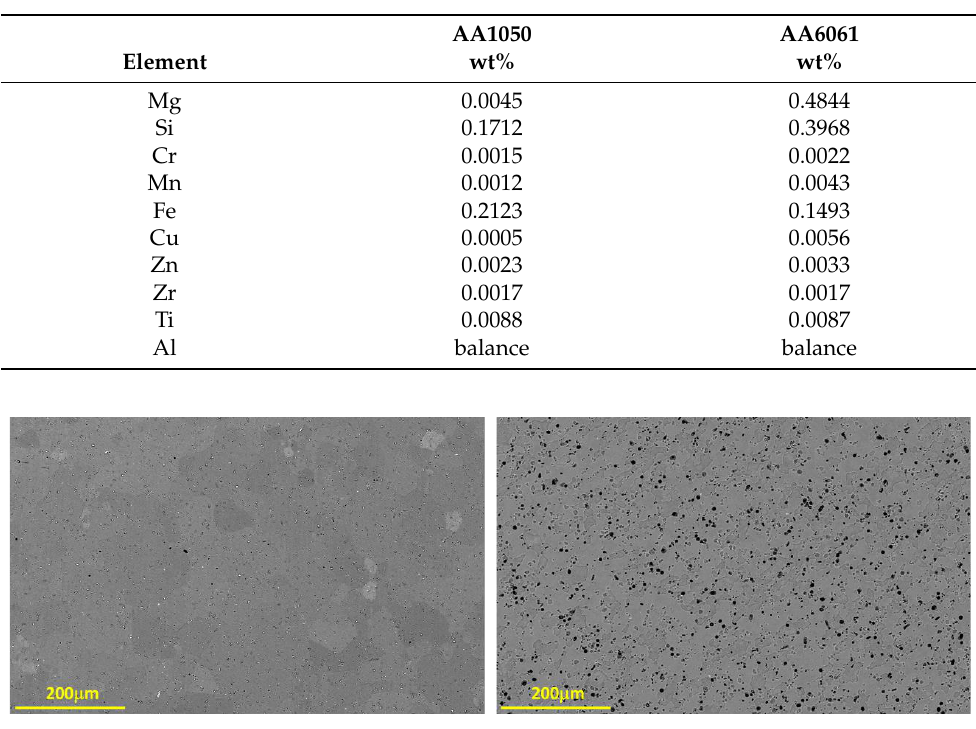
Table 1. Diffusion bonding parameters used to bond AA1050 to AA6061. Specimen No.